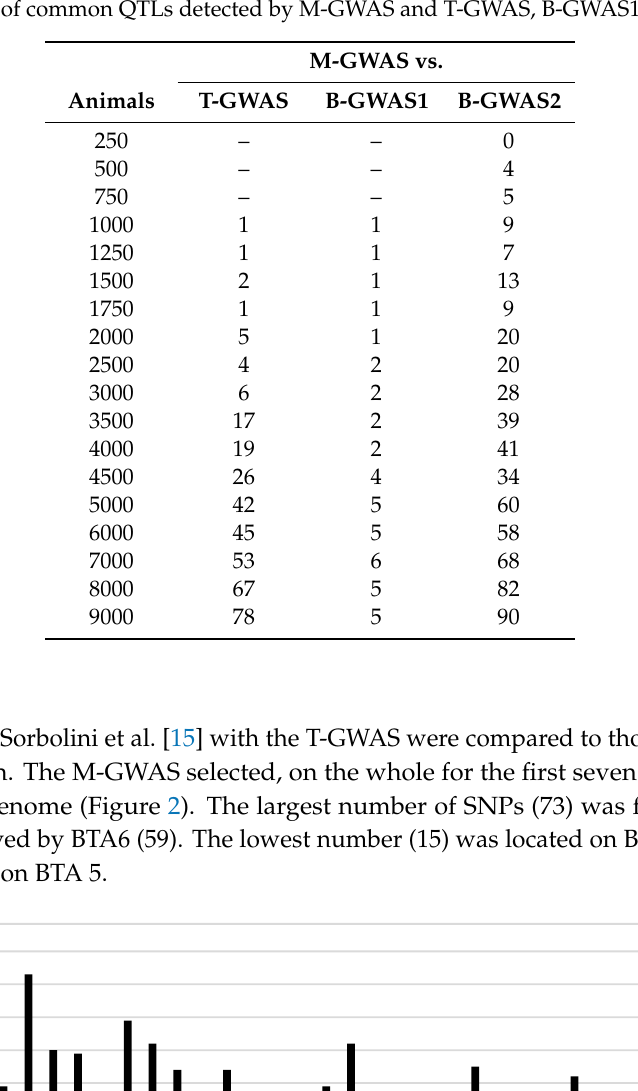
Table 4. Number of associated markers both in traditional and multivariate GWAS and in common markers (T-GWAS and M-GWAS, respectively). The minimum number of discriminant SNPs in the multivariate approach are also displayed.